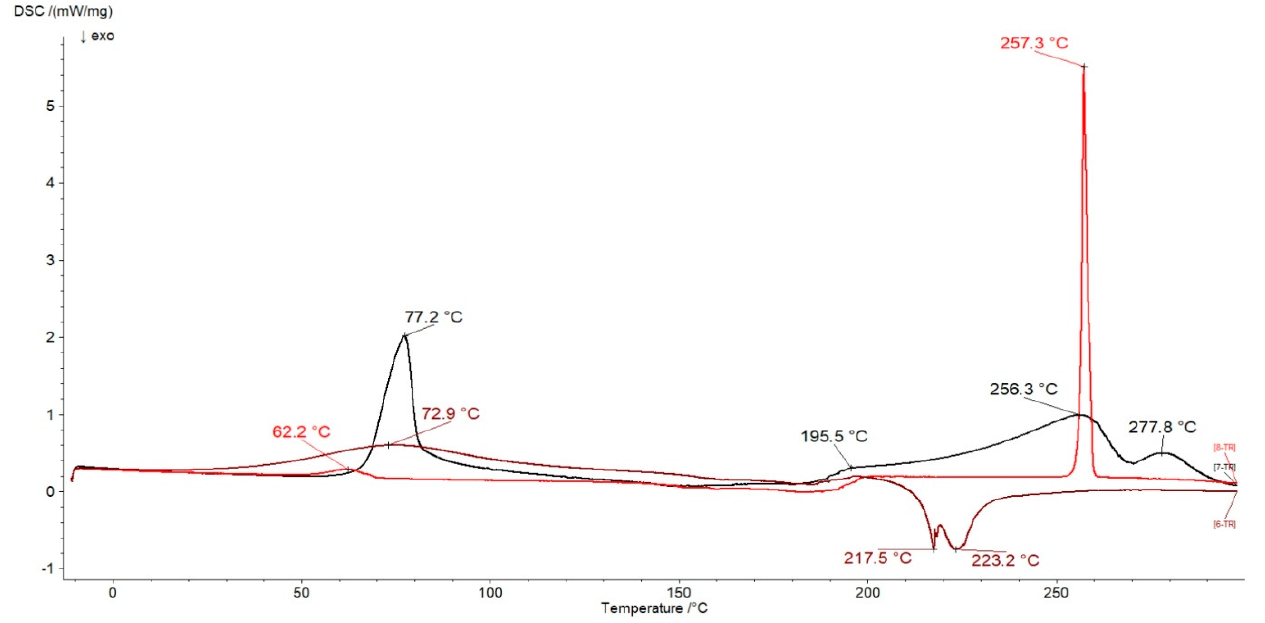
Figure 11. The thermograms of L (black line), N (red line) and F1 (brown line).